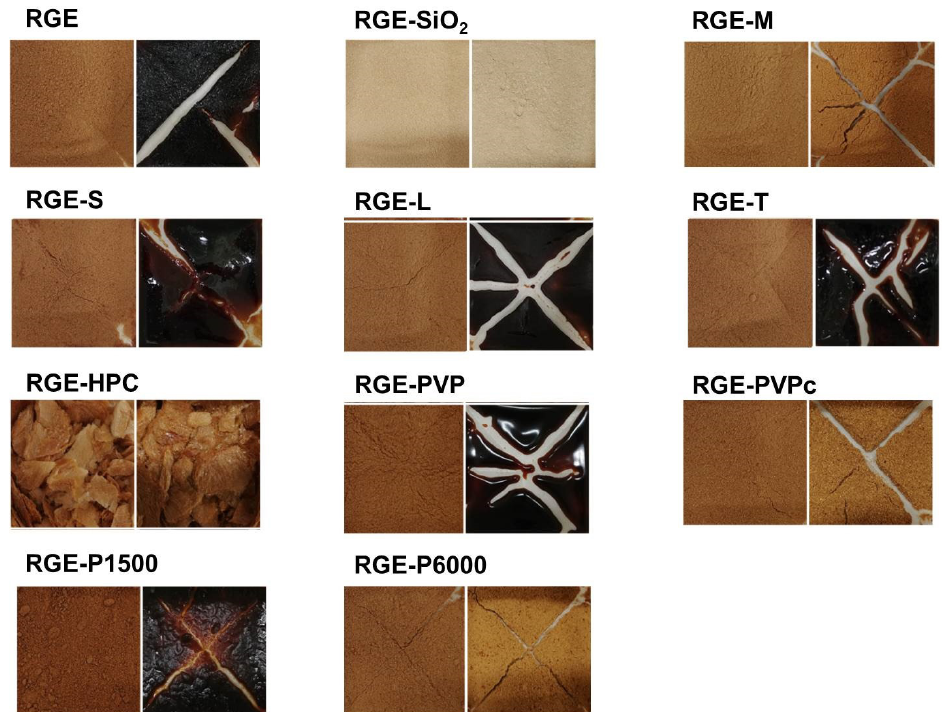
Figure 3. Hygroscopic evaluation of the solid dispersion of red ginseng extract (RGE) with various hydrophilic carriers before (left) and after (right) storing in a thermo-hygrostat incubator with increasing humidity (from 30% RH to 70% RH) for 25 days at 30 °C. RGE: solid dispersion of red ginseng extract; RGE-SiO 2 : solid dispersion of RGE with silicon dioxide; RGE-M: solid dispersion of RGE with mannitol; RGE-S: solid dispersion of RGE with sucrose; RGE-L: solid dispersion of RGE with lactose; RGE-T: solid dispersion of RGE with trehalose; RGE-HPC: solid dispersion of RGE with hydroxypropyl cellulose; RGE-PVP: solid dispersion of RGE with polyvinyl pyrrolidone; RGE-PVPc: solid dispersion of RGE with cross-linked polyvinyl pyrrolidone; RGE-P1500: solid dispersion of RGE with PEG1500; RGE-P6000: solid dispersion of RGE with PEG6000.